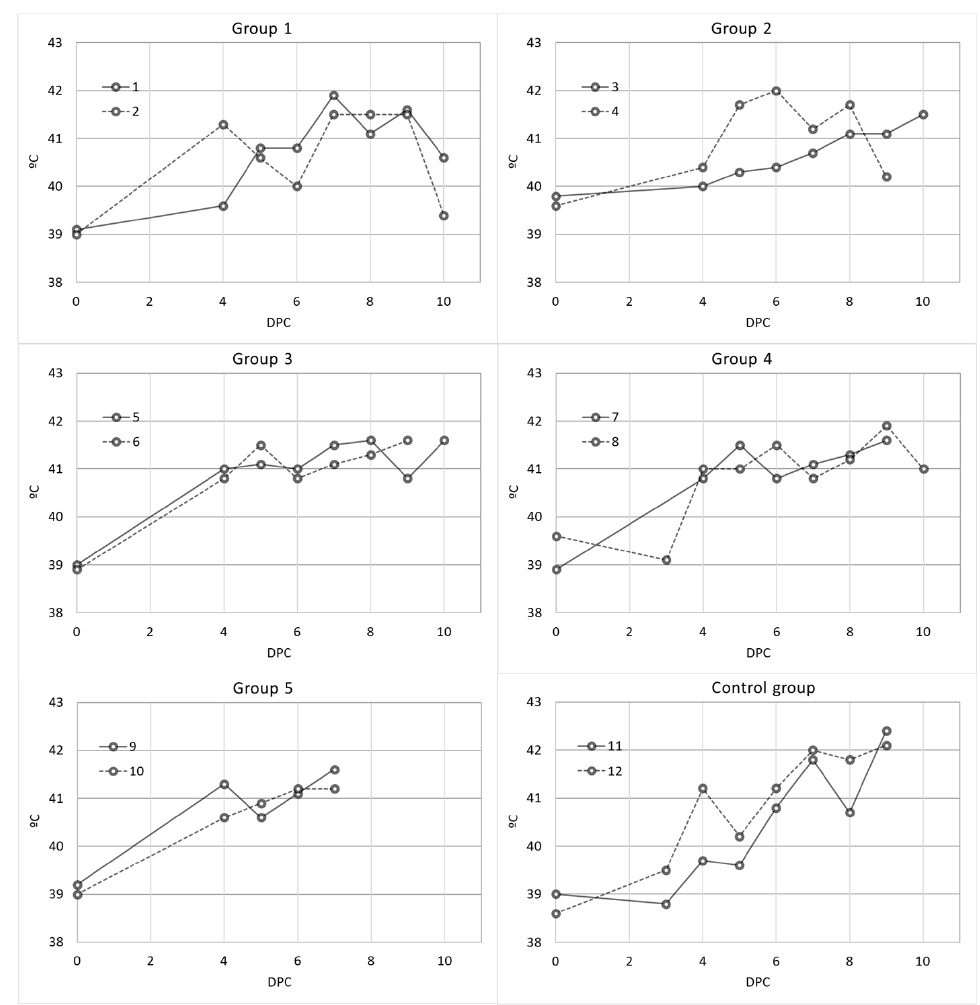
Figure 2. Individual post-challenge temperatures of domestic pigs from the different vaccinated groups: Group 1 (Pol16-inactivated, MF59), Group 2 (Pol16-inactivated, Silica oil), Group 3 (Pol16-inactivated, mGNE), Group 4 (Pol16-inactivated, Montanide ISA201), Group 5 (Pol16-inactivated), and control group.